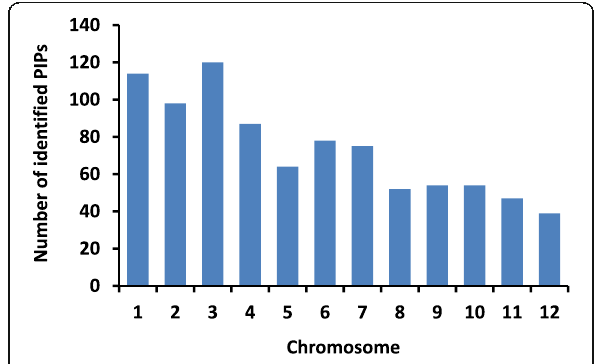
Fig. 1 Chromosomal distribution of putative rice PIPs.